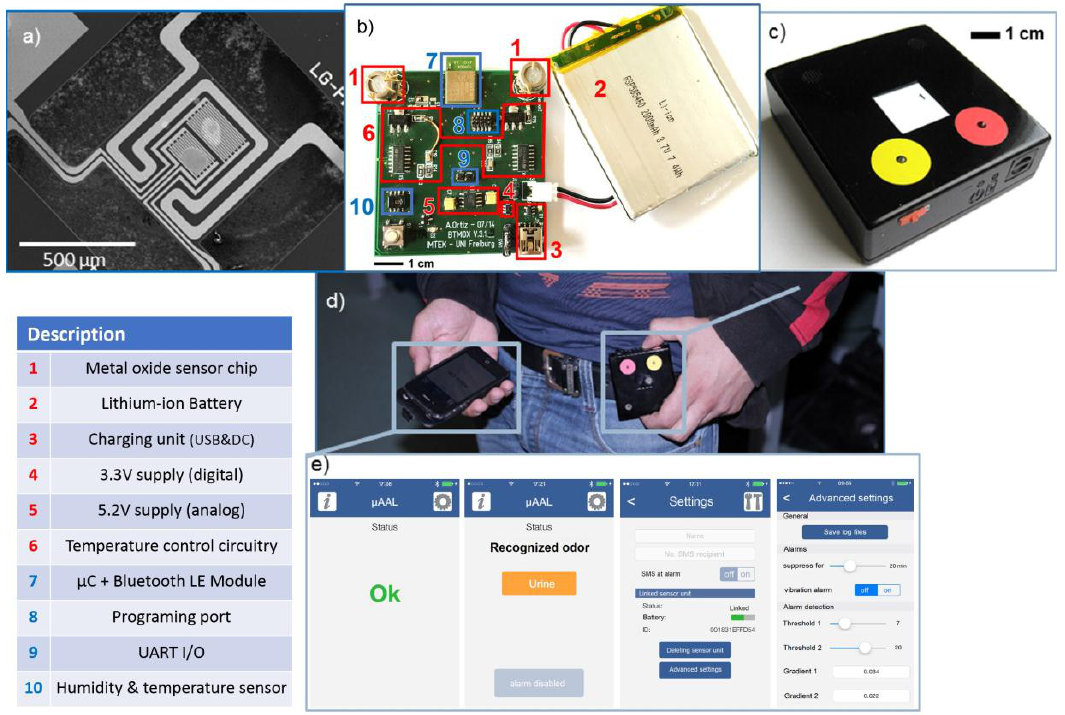
Figure 3. ( a ) The micro-machined suspended hotplate sensor chip used in the setup features a heating structure and two interdigitated electrode structures. The image has been taken using a scanning electron microscope at 80 × magnification; ( b ) The complete hardware of the sensor module (PCB & battery); ( c ) Sensor module package with LEDs to indicate incontinence related odors to user directly; ( d ) Photo of the system as it may be used with a commercially available smartphone and the sensor module; ( e ) Example of a possible realization of the human